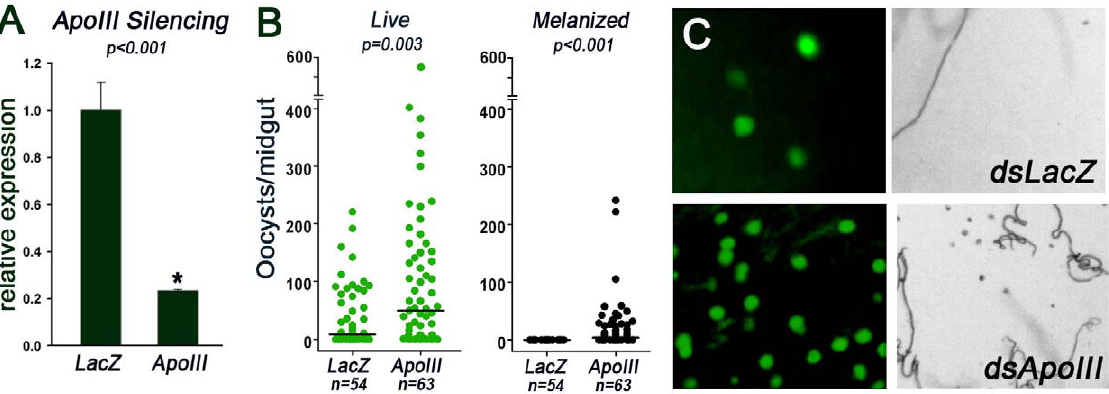
Figure 5. Effect of AgApoLp-III silencing on Plasmodiumberghei infection in Anophelesgambiae (G3 strain) females. (A) Relative abundance of AgApoLp-III mRNA in G3 mosquitoes injected with AgApoLp-III dsRNA (ApoIII) or control LacZ dsRNA ( LacZ ). (B) Effect of AgApoLp-III silencing on the number of live oocysts (green dots; ) and melanized parasites (black dots; ) in midguts analyzed seven days post infection. Dots represent the number of parasites present on individual midguts, and the median number of parasites is indicated by the horizontal line. Distributions are compared using the Kolmogorov-Smirnov test; n= number of mosquitoes, * indicates significant decrease in mRNA levels relative to dsLacZ -injected controls. (C) Representative field to illustrate the effect of AgApoLp-III silencing on Plasmodium infection 7 days post-feeding. Live oocysts express GFP and exhibit green fluorescence (right panels), while melanized parasites can be observed as dark spots in bright field images (left panels).